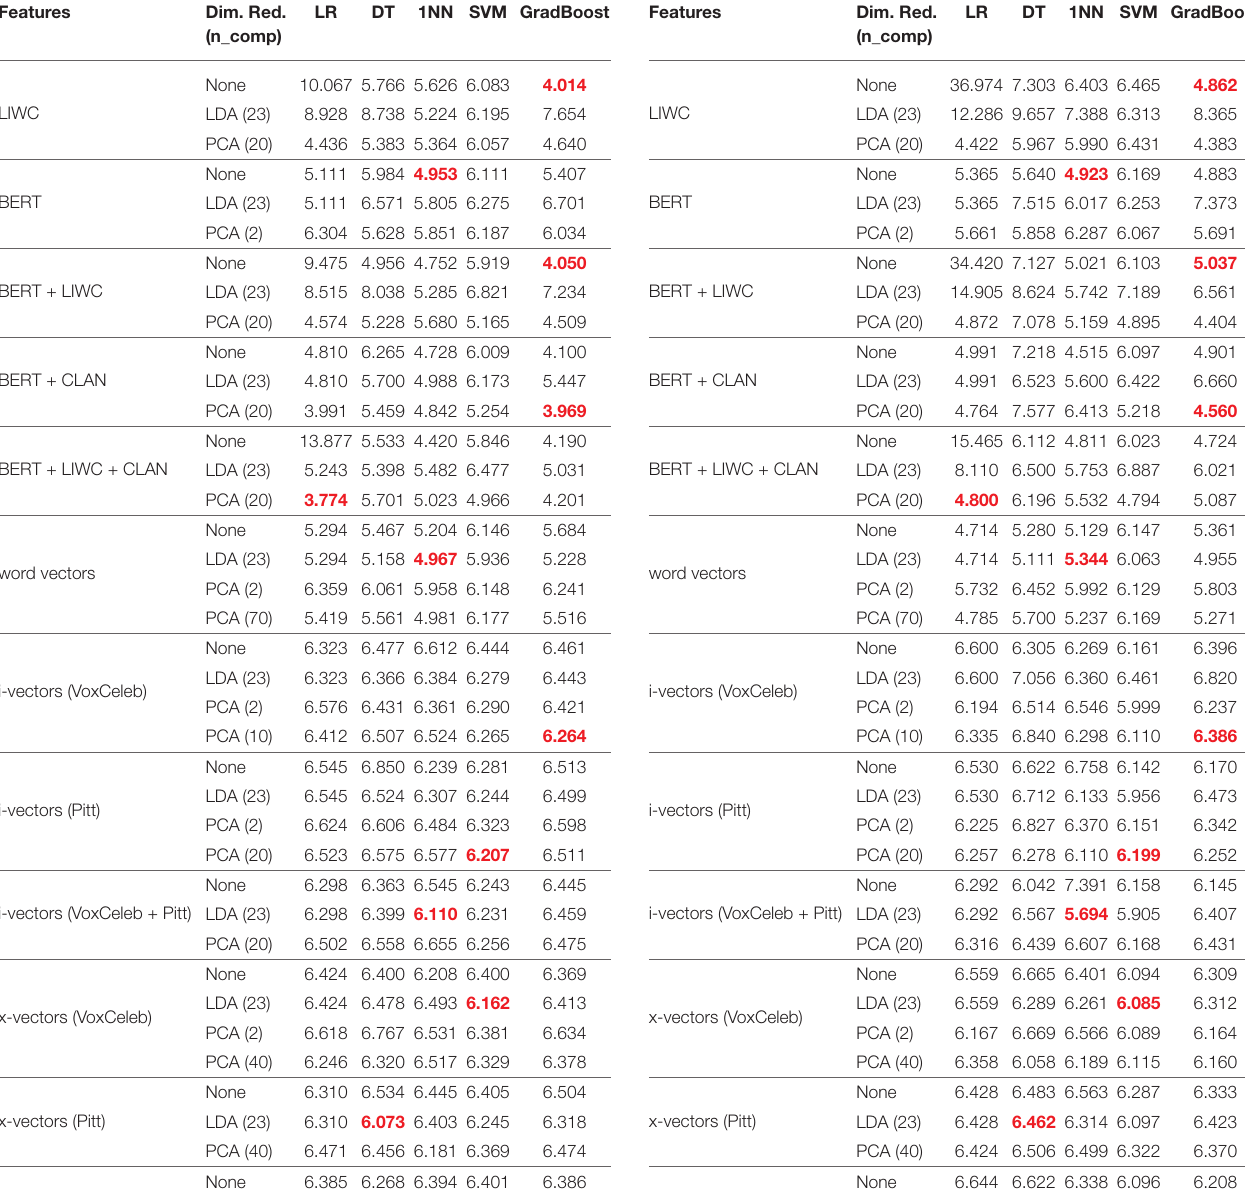
TABLE 6 | RMSE scores for classifiers evaluated on the test set. The results for the best-performing models during cross-validation are red.